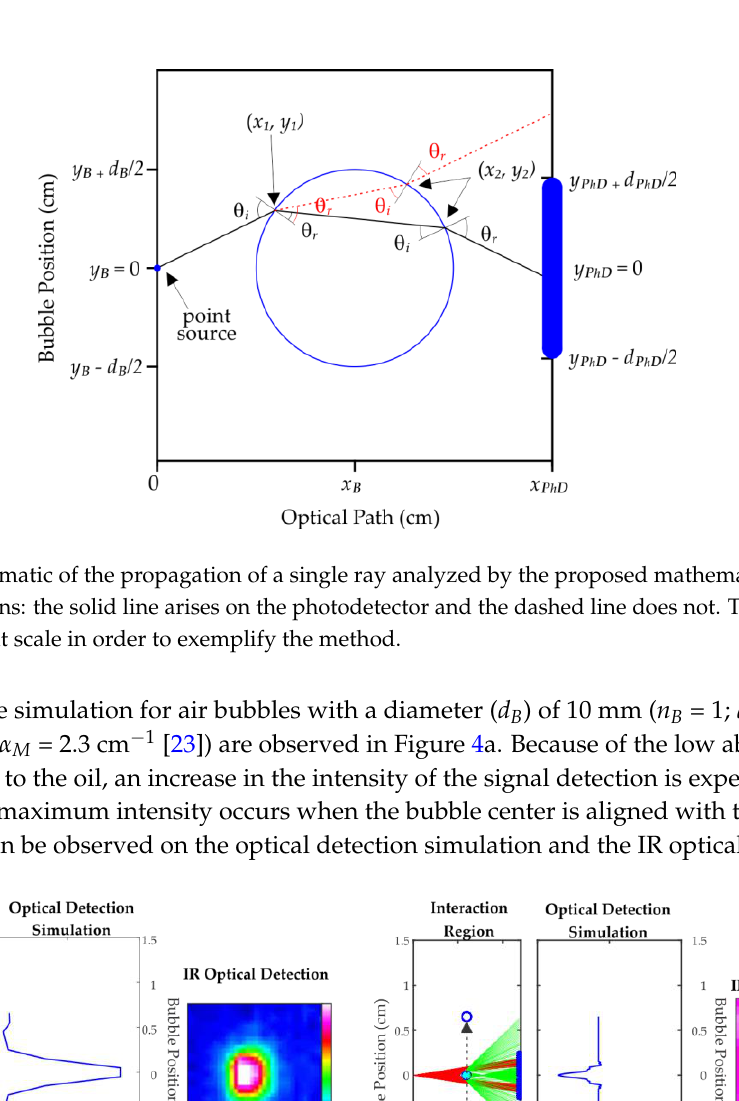
Figure 4. Simulation of the evolution of air bubbles flowing in crude oil ( n M = 1.5; α M = 2.3 cm −1 ). ( a ) d B = 10 mm; n B = 1; α B = 0; ( b ) d B = 1 mm; n B = 1; α B = 0.